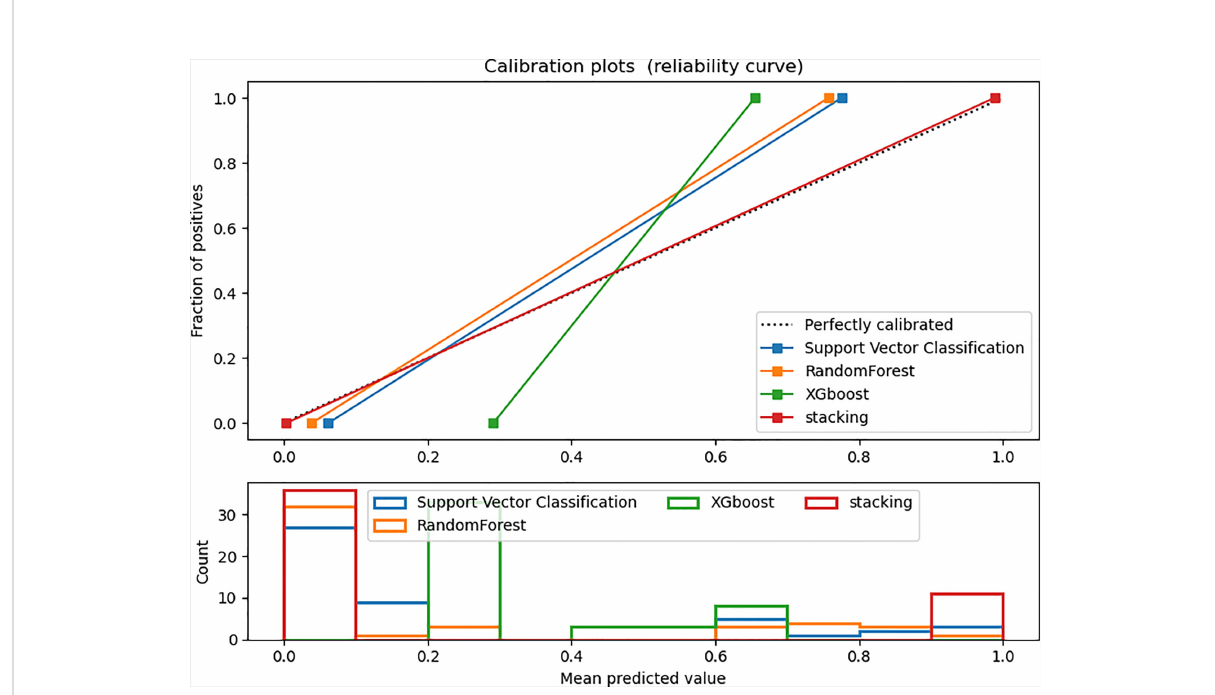
FIGURE 5 Calibration curve in the testing dataset. The ideal prediction curve is represented by the black dashed line. The model is more accurate as the actual prediction curve gets closer to the dashed line. The bar chart below depicts the average distribution of four models ’ predicted